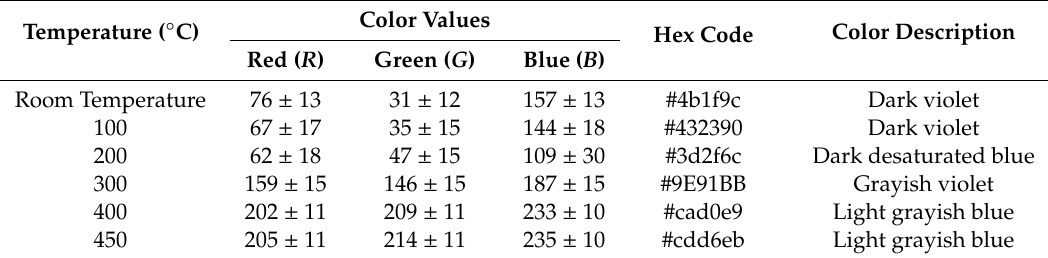
Figure 8. Color changes and their standard deviations of the coating surface obtained in RGB values. Table 2. Coatings— RGB color change values and their corresponding color charts.